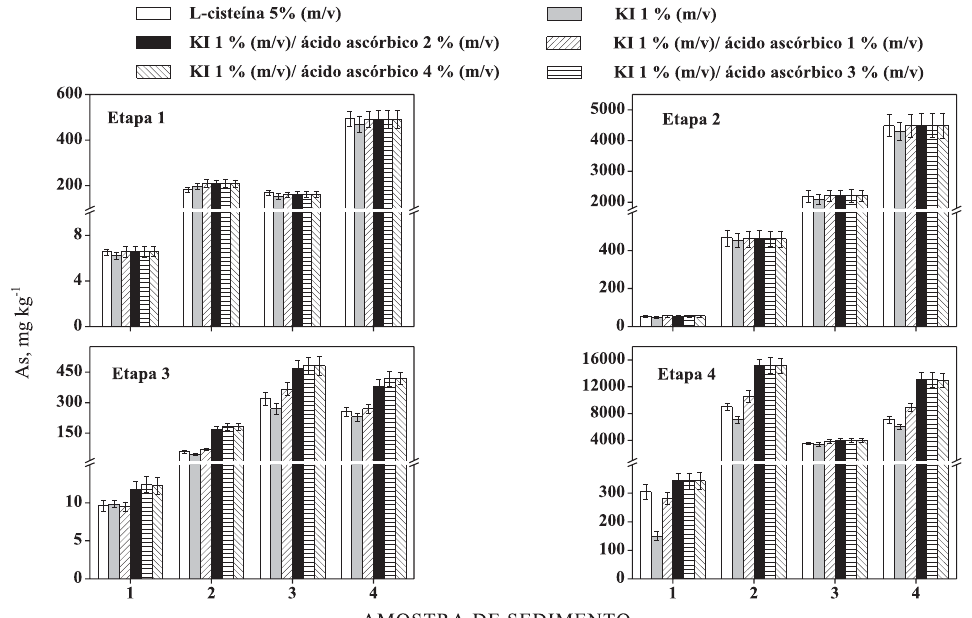
Figura 1. Teores de As nos extratos obtidos pela aplicação do método BCR de extração sequencial em quatro amostras de sedimentos, em função das condições de pré-redução do As(V)